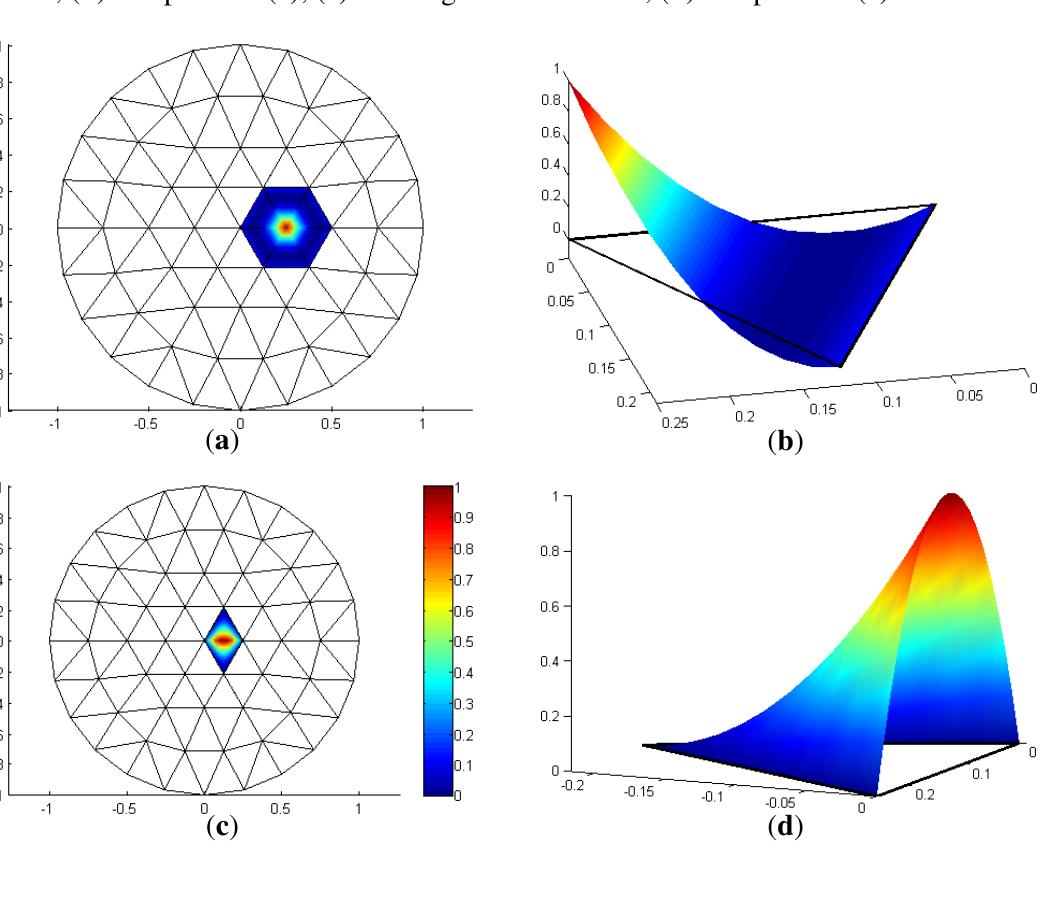
Figure 1. C 0 quadratic basis functions. ( a , c ) top view with height scale. ( a ) Nodal